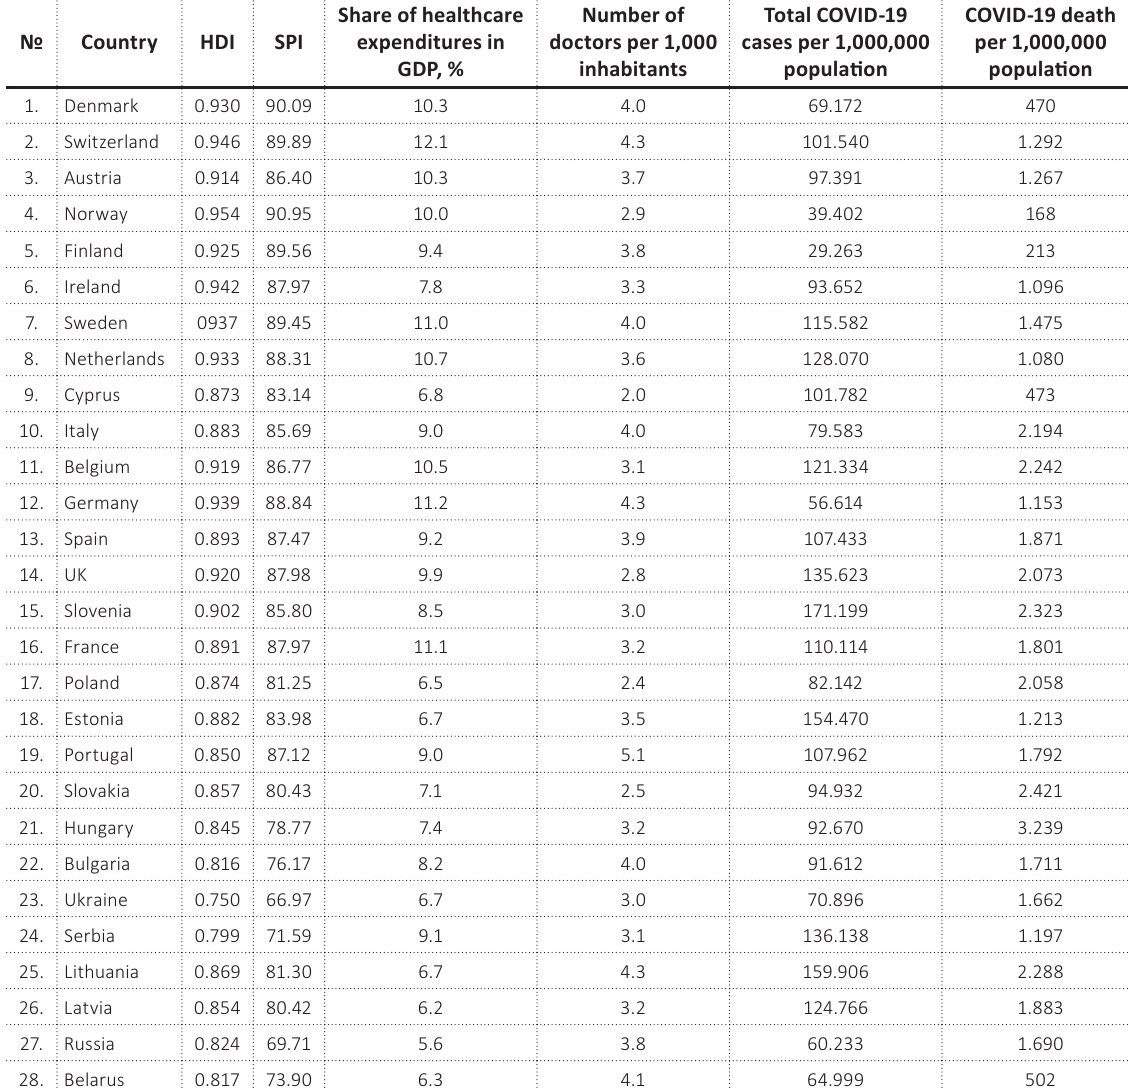
Table 1. Social indicators of the healthcare system in some European